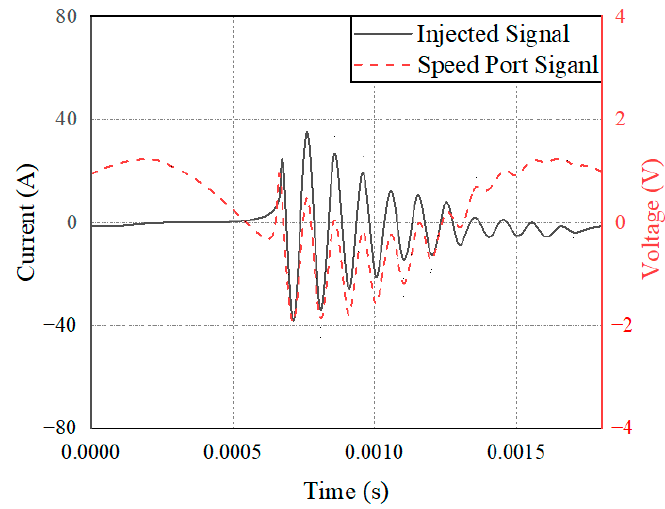
Figure 17. Speed sensor terminal coupling voltage signal.